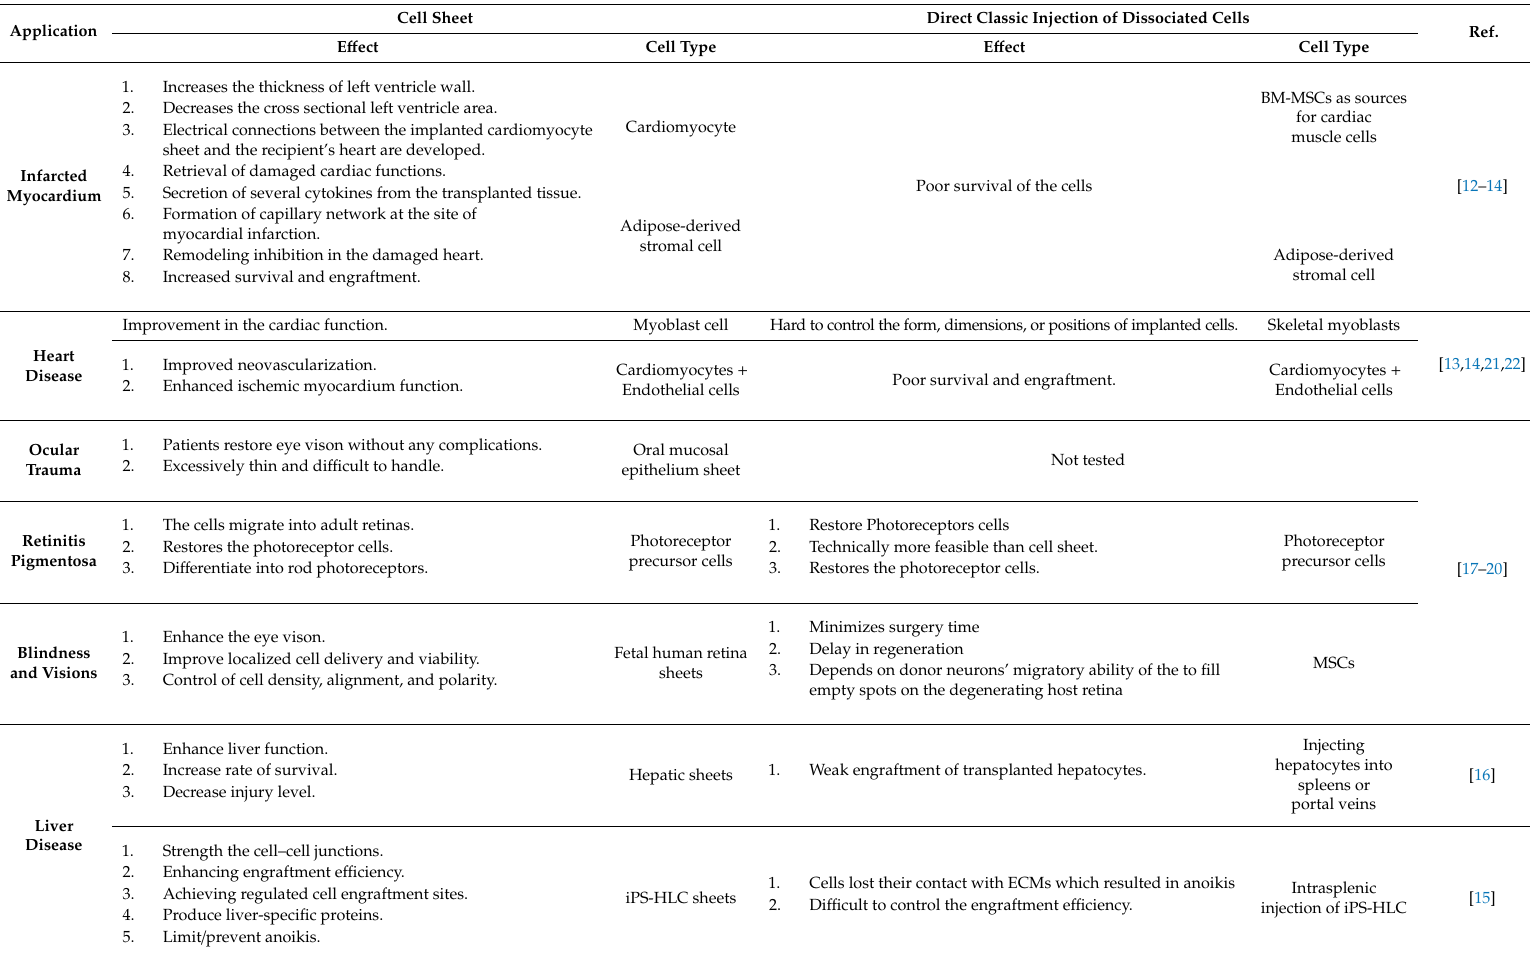
Table 1. 3-D cell sheet method vs classic cell suspension injection method in clinical and preclinical applications.